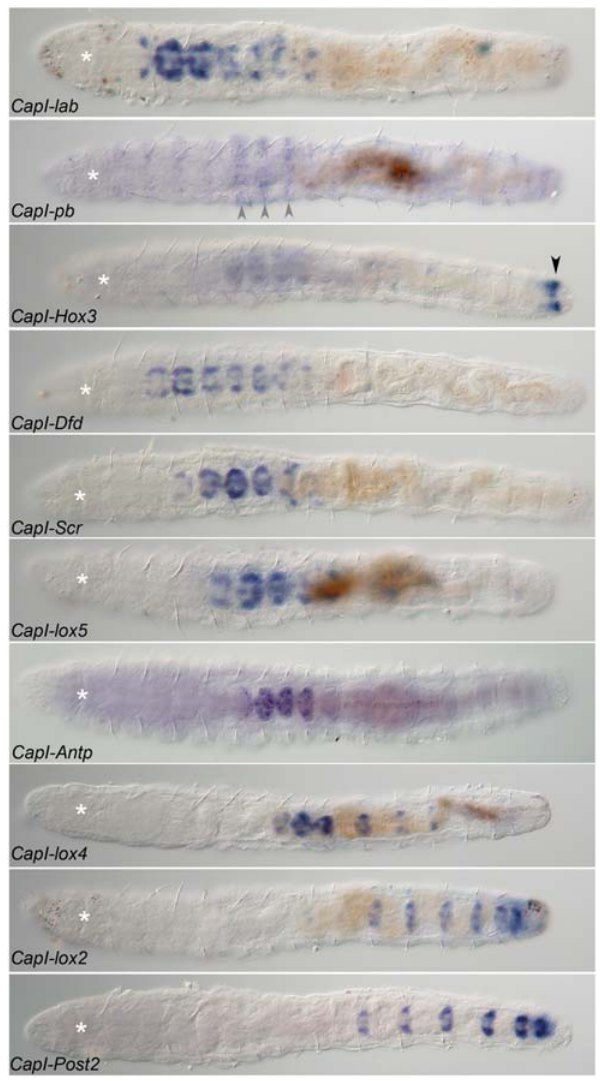
Figure 13. Hox gene expression in juveniles. All panels are ventral views with anterior to the left. Asterisk marks the position of the mouth. Gene names are in the lower left corner of each panel. Age of animals shown is 3 d after metamorphosis. Capitella Hox gene expressions are largely limited to a subset of VNC ganglia in juveniles. Exceptions include CapI-Hox3 , which is expressed in the prepygidial growth zone (black arrowhead), and CapI-pb , which shows weak epidermal stripes (gray